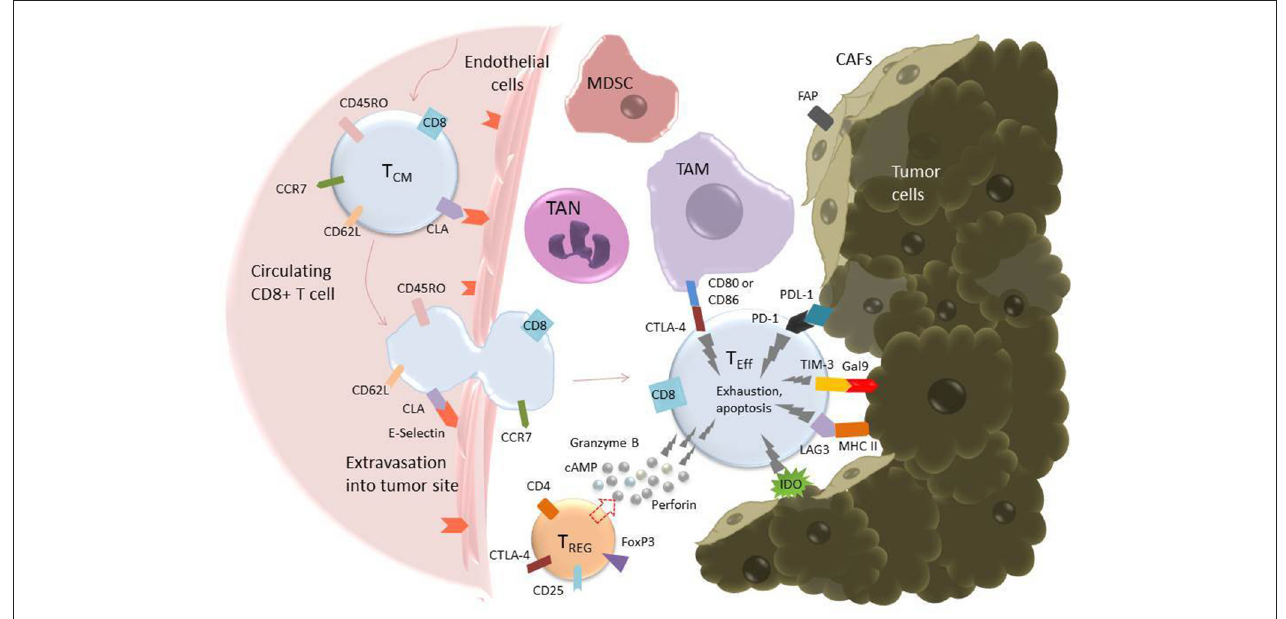
FIGURE 2 | T cell extravasation into the TME and subsequent exhaustion mediated by inhibitory ligands on tumor and tumor-associated cells. Endothelial cells experiencing inflammation express adhesion molecules including selectins, vascular cell adhesion molecule-1 (VCAM-1), and intercellular adhesion molecule (ICAM-1). P- and E-Selectins (the latter shown in the figure) bind cutaneous lymphocyte antigen (CLA), a specially glycosylated form of P-selectin glycoprotein ligand 1 (PSGL-1) that is expressed on activated T cells (114). VCAM-1 binds very late antigen-1 (VLA-4) and ICAM-1 binds lymphocyte function-associated antigen-1 (LFA-1) (115). Upon binding endothelial cell ligands, T cells undergo tethering and rolling before adhering to the endothelium and transmigrating through it as shown. Once in the tumor microenvironment, T cells are in an environment full of tumor-associated, immunosuppressive cells including tumor-associated macrophages (TAMs), tumor-associated neutrophils (TANs), myeloid-derived suppressor cells (MDSCs), T-regulatory cells (Tregs), and cancer-associated fibroblasts (CAFs) (95). These cells express inhibitory molecules, including CD80/CD86, which bind the inhibitory receptor CTLA-4 (pictured), and secrete soluble factors that suppress or cause apoptosis in T cells. CAFs also serve as a physical barrier between T cell and tumor cell. Additionally, tumor cells themselves express ligands such as Gal9 and PDL-1, which bind to the T cell inhibitory receptors TIM-3 and PD-1, respectively. All these factors serve to promote an “exhausted” phenotype in the T cell, characterized